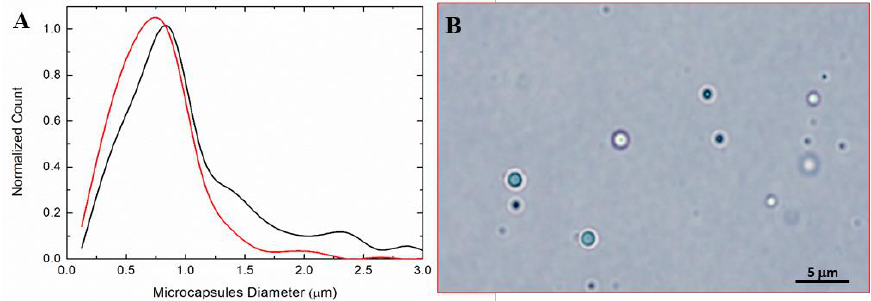
Figure 10. ( A ) Size distribution of PG mc with VitD at day one (black) and after one month (red). ( B ) Optical microscopy image of PG mc after one month.